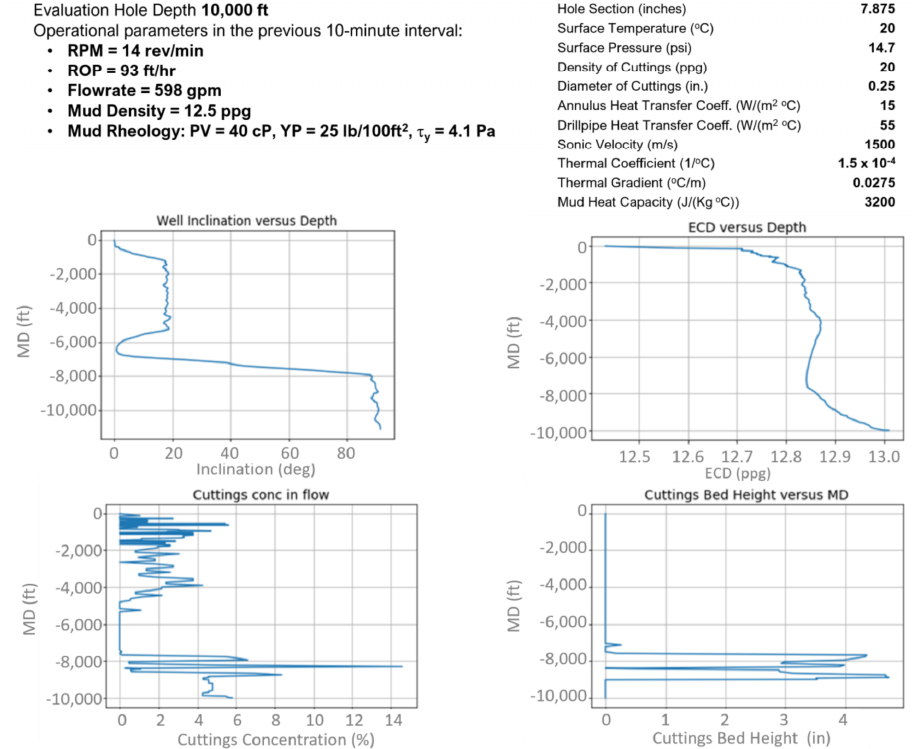
Figure 5. State of the system at a 10,000 foot hole depth after tracking its evolution from the surface.